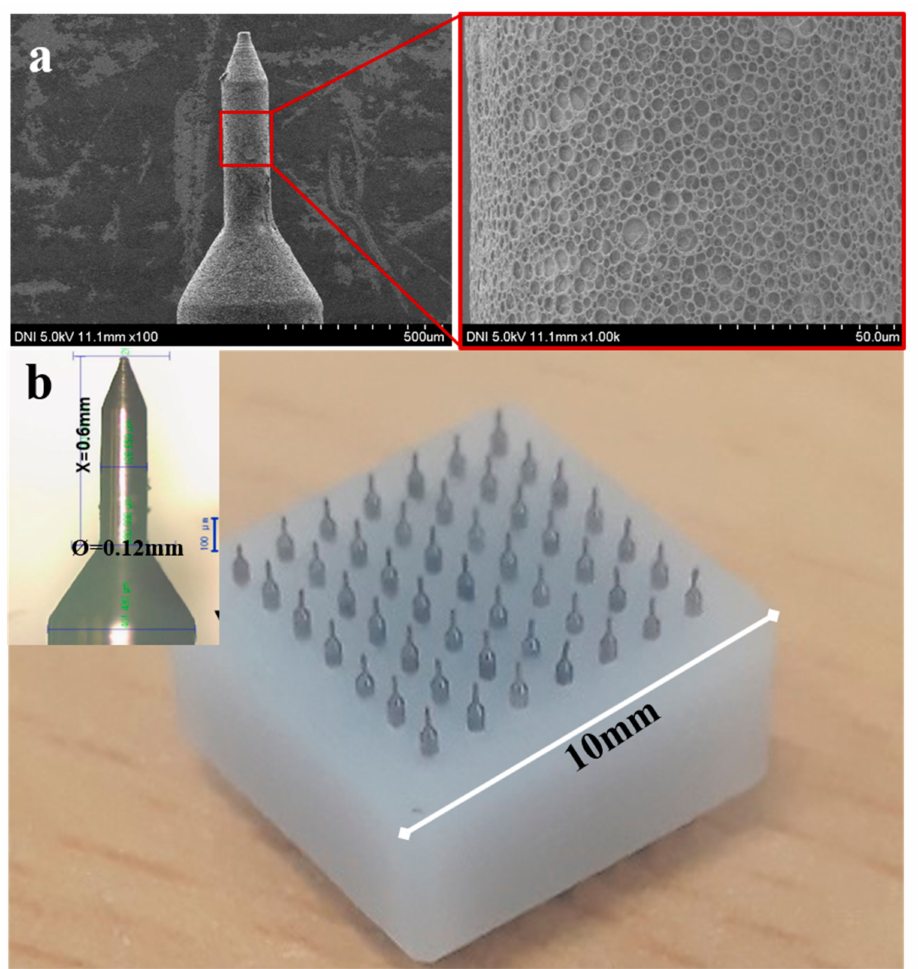
Figure 2. SEM images and Stereo micrograph of the pH-responsive porous coated microneedles (MNs): ( a ) SEM images at two di ff erent magnifications; ( b ) MN array (inset is magnified stereo micrograph of MN). The length and diameter of stainless-steel (SS) MN were 600 µ m and 120 µ m,